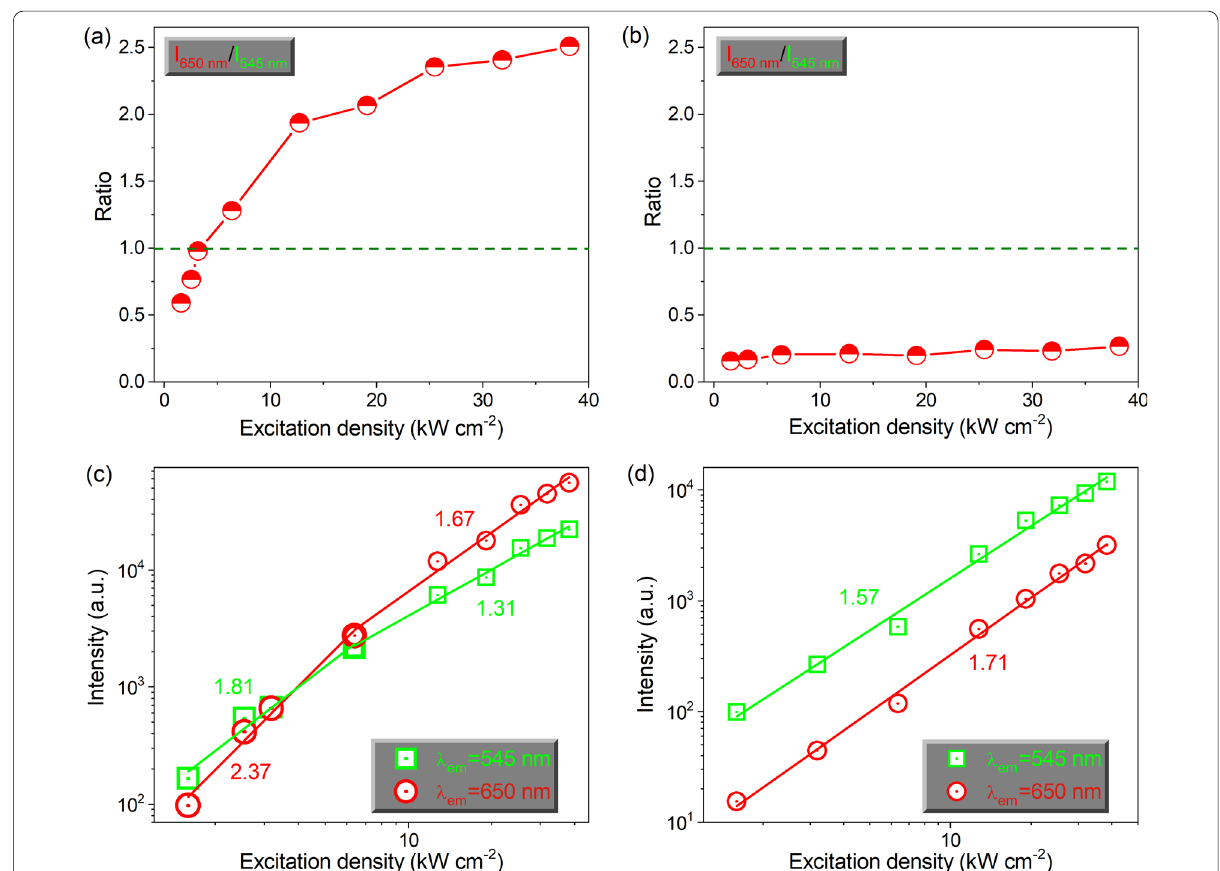
Fig. 3 The ratios of R / G for single a β-NaYF 4 :98%Yb,2%Er, and b β-NaYF 4 :20%Yb,2%Er microcrystal as a function of the excitation intensity. The dependences of the UCL intensity on the excitation intensity for single c β-NaYF 4 :98%Yb,2%Er, and d β-NaYF 4 :20%Yb,2%Er microcrystal. All excitation wavelengths are at ~ 808